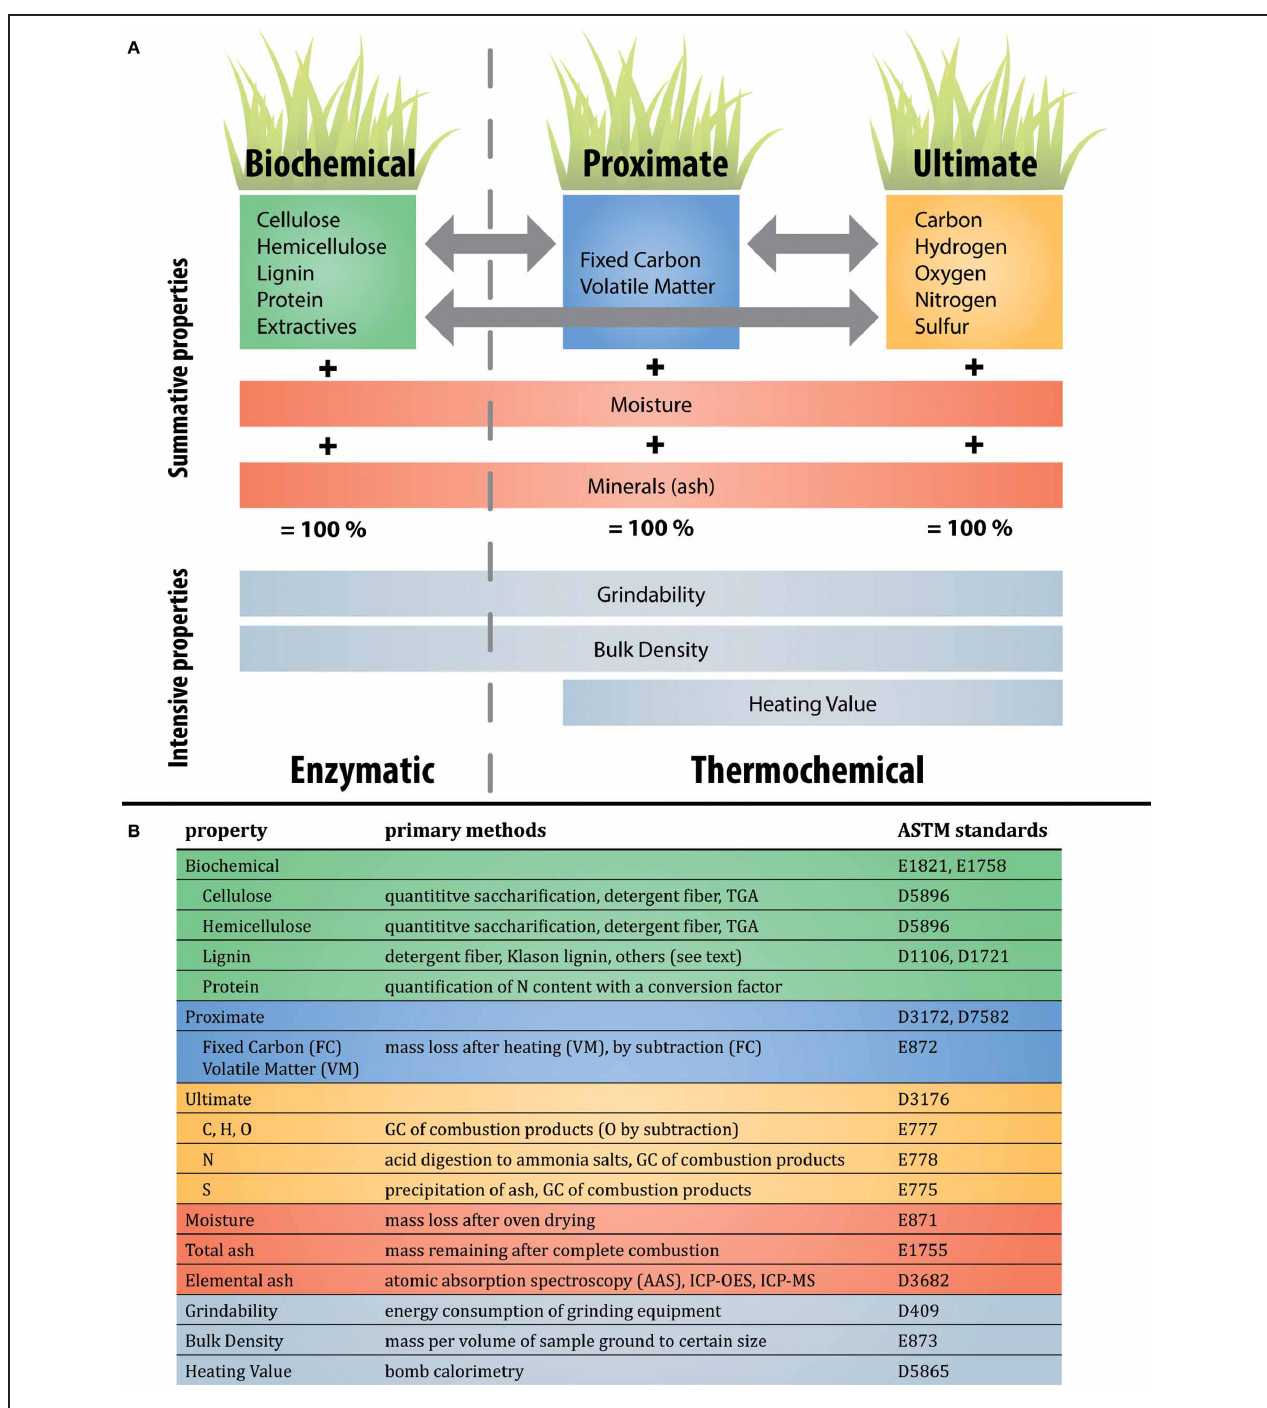
FIGURE 2 | Overview of the relationships between biomass traits and properties, and common methods of quantification. Colors for each property are maintained throughout Figure 2 . (A) Biomass characterization in terms of summative properties (shown in green, blue, orange, and red) and intensive properties (shown in gray). Three common paradigms for describing biomass are inter-related: biochemical, proximate, and ultimate. While enzymatic conversion has focused on characterizing biomass in a biochemical paradigm, two alternatives more appropriate for thermochemical conversion are proximate and ultimate